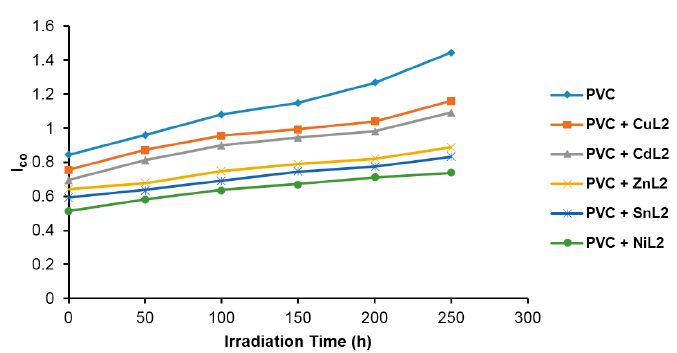
Figure 4. Effect of irradiation time (250 h) on I CO for PVC films (40 μ m thickness) containing ML 2 (0.5 wt %).